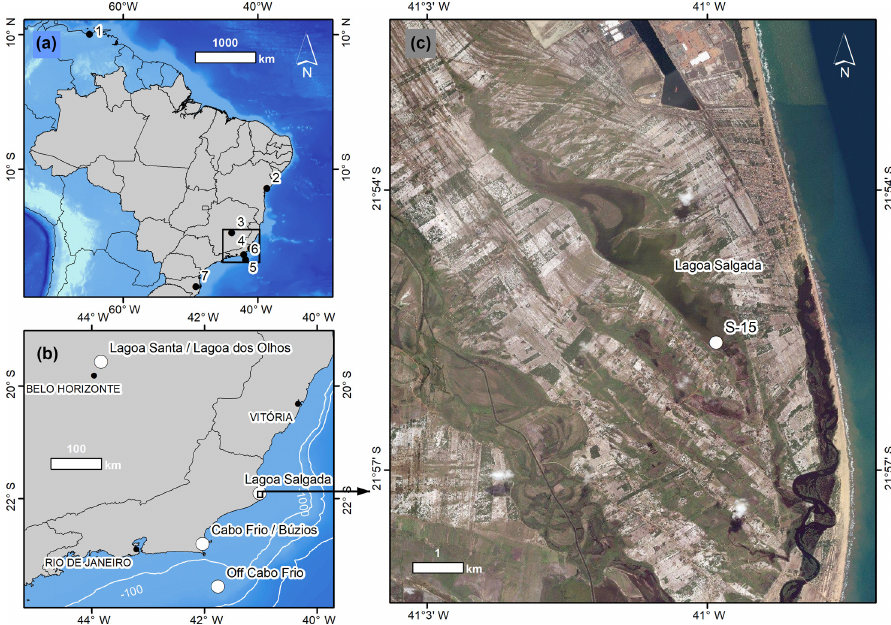
Figure 1. Location map of study area. (a) Brazil within South America. Black box indicates the location of (b) . Numbers refer to sites mentioned in Table 1. (b) Southeastern Brazil with state capitals and sites mentioned in the text. (c) Location of core S-15 within Lagoa